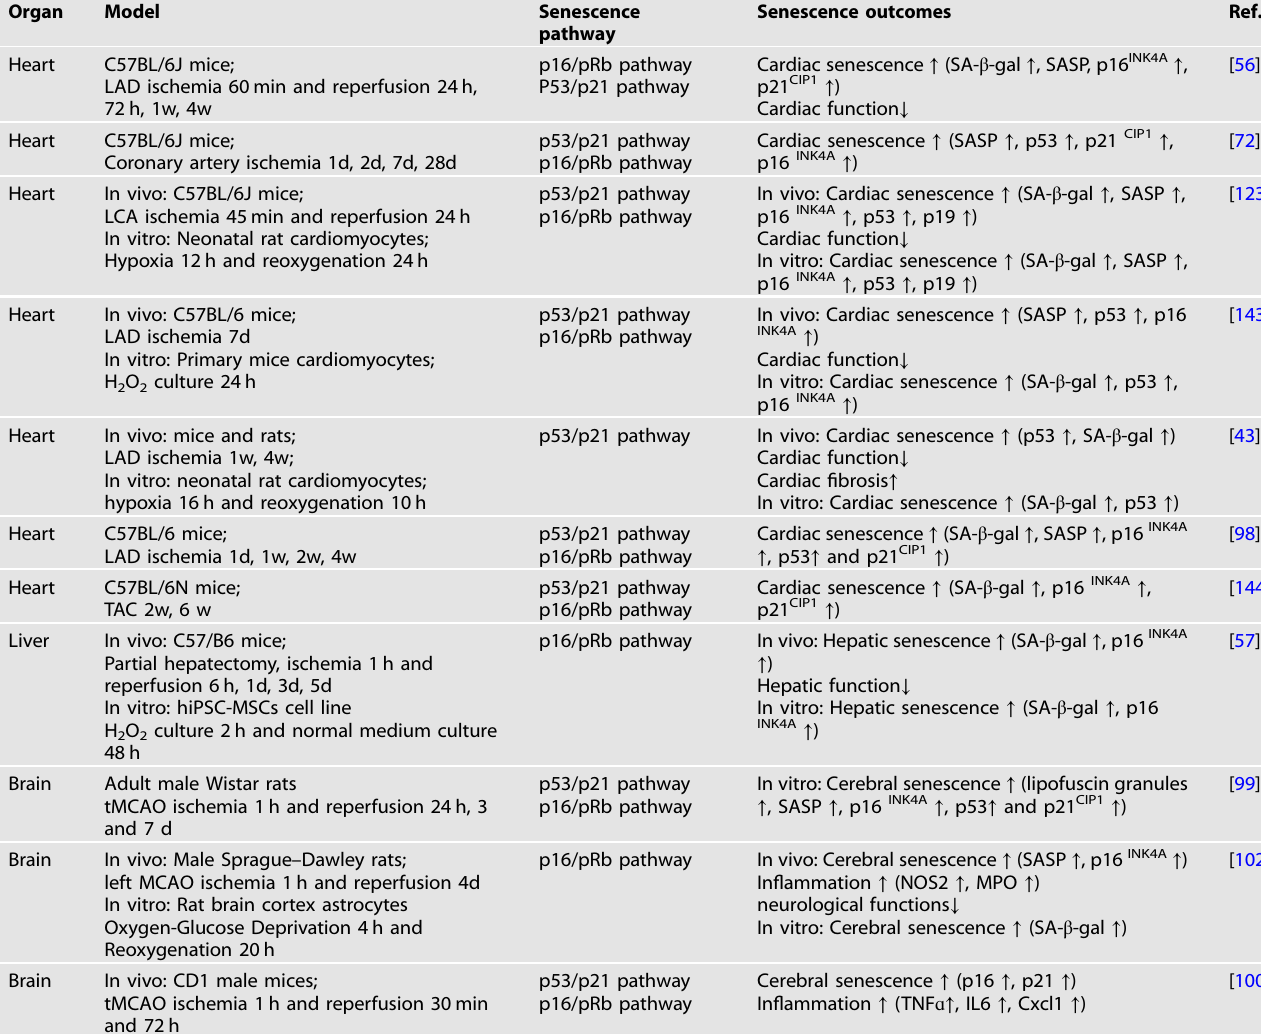
Abbreviations: NRK-49F cells normal rat kidney-49F cells, LAD left anterior descending artery, LCA left coronary artery, TAC transverse aortic constriction, hiPSC- MSCs MSCs derived from human induced pluripotent stem cells, OGD/R oxygen-glucose deprivation/reoxygenation, tMCAO transient middle cerebral artery occlusion, MCAO middle cerebral artery